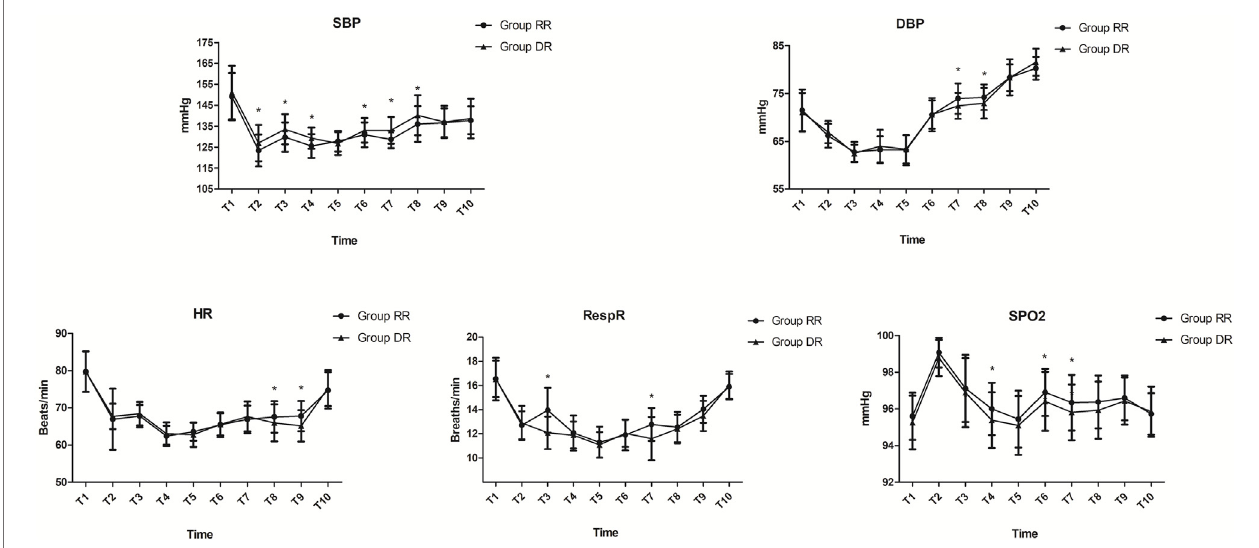
FIGURE2 | Hemodynamic measurements.In theRR group, SBP wassigni fi cantly decreased from T2 toT8exceptat T5, while DBP wassigni fi cantly increased at T7andT8( p < 0.05).RespRwassigni fi cantlyincreasedatT3andT7,whileHRwassigni fi cantlyincreasedatT8andT9intheRRgroup( p < 0.05).SpO2wassigni fi cantly increasedfrom T4toT7except atT5inthe RRgroup( p < 0.05).AbbreviationsDBP, diastolicblood pressure;HR,heartrate;RespR, respiratory rate;RR, remimazolam tosilate-remifentanil (RT-RF); SBP, systolic blood pressure; SpO2, oxygen saturation. Time metrics are as follows: T2, immediately before start of procedure;